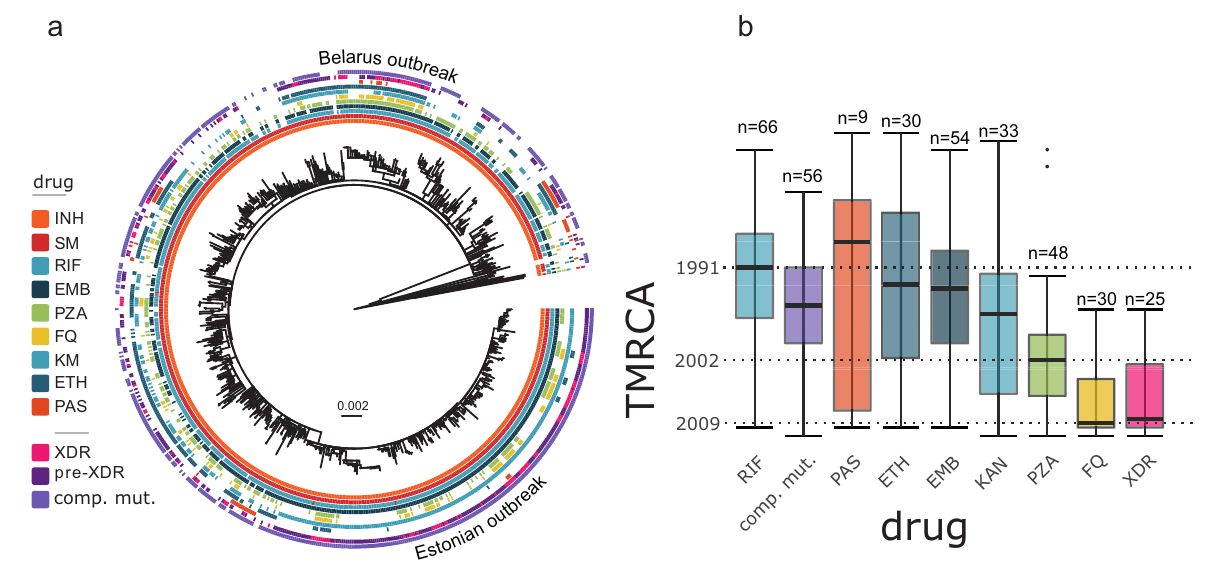
Fig. 3 | Antibiotic resistance pro fi les and emergence timing. a Bayesian time tree based on 5264 variable positions (SNPs) among the 720 W148 strains and 11 lineage 2 outgroup strains. The different crowns are showing the presence ( fi lled box) or absence (empty box) of mutations conferring resistance to dif- ferent drugs: INHIsoniazid, SMStreptomycin, RIFRifampicin, EMBEthambutol, PZAPyrazinamide, FQFluoroquinolones, KMKanamycin, ETHEthionamide and PASPara-aminoslicylic acid; strains drug resistance pro fi les: XDR, Pre-XDR and